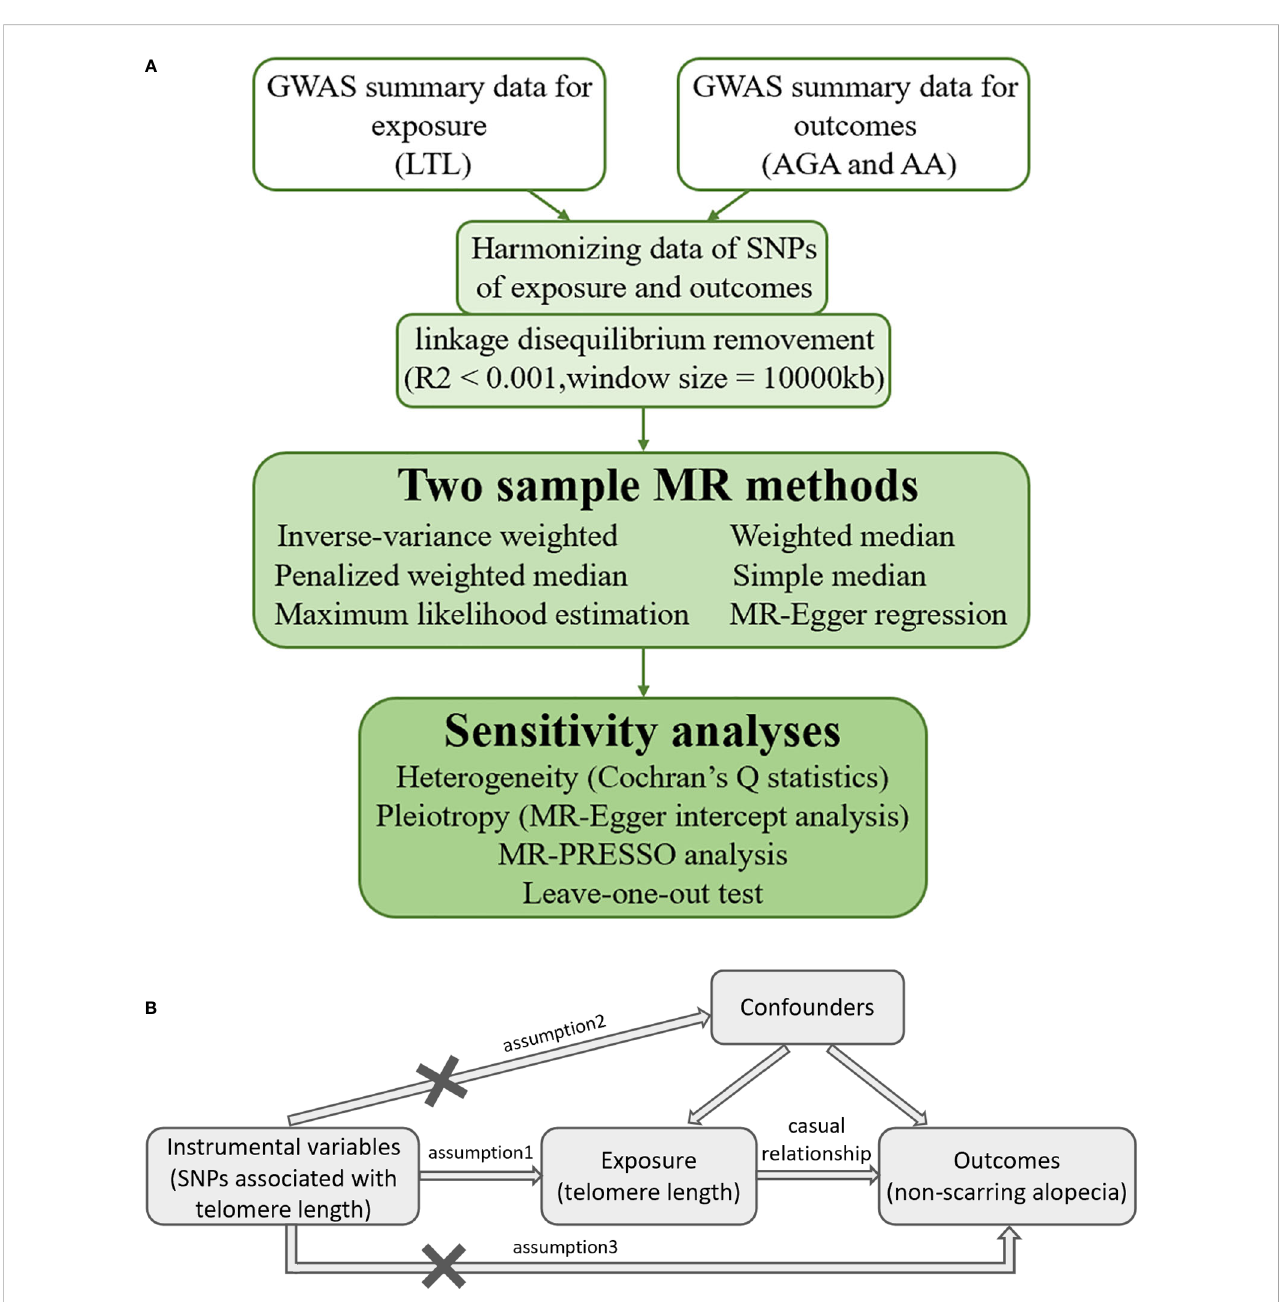
FIGURE 1 (A) Detailed fl owchart of the current two-sample Mendelian randomization study. (B) Mendelian randomization assumptions. GWAS , genome-wide summary association study; LTL , leukocyte telomere length; AGA , androgenetic alopecia; AA , alopecia areata; SNP , single nucleotide polymorphism; MR , Mendelian randomization; MR-Egger , Mendelian randomization-Egger; MR-PRESSO , Mendelian randomization pleiotropy residual sum and